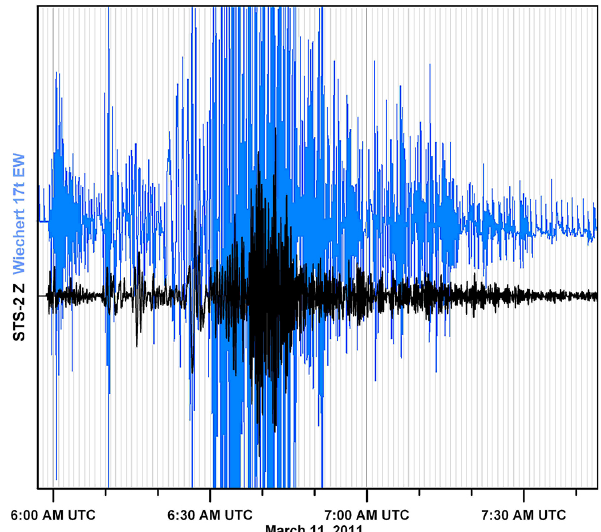
Figure 9. Example: record of the 11 March 2011 T¯ohoku earth- quake as observed with the vertical (Z) component of the Streck- eisen STS-2 seismometer (black) in the Erdbebenwarte (Station GTTG) and the east–west (EW) component of the 17t horizontal seismograph (blue). O ff set between graphs for visibility. No further scientific processing is applied to the